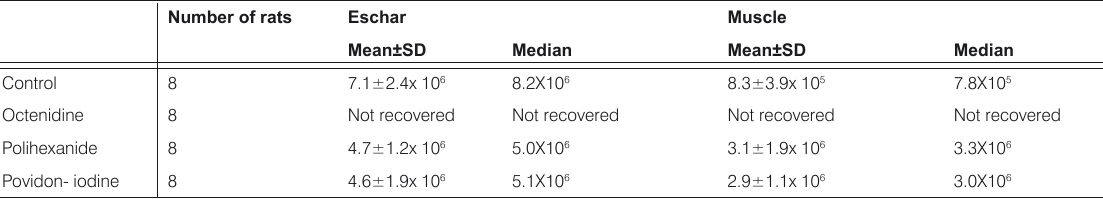
Table 2. Comparison of quantitative cultures performed on burn eschar and